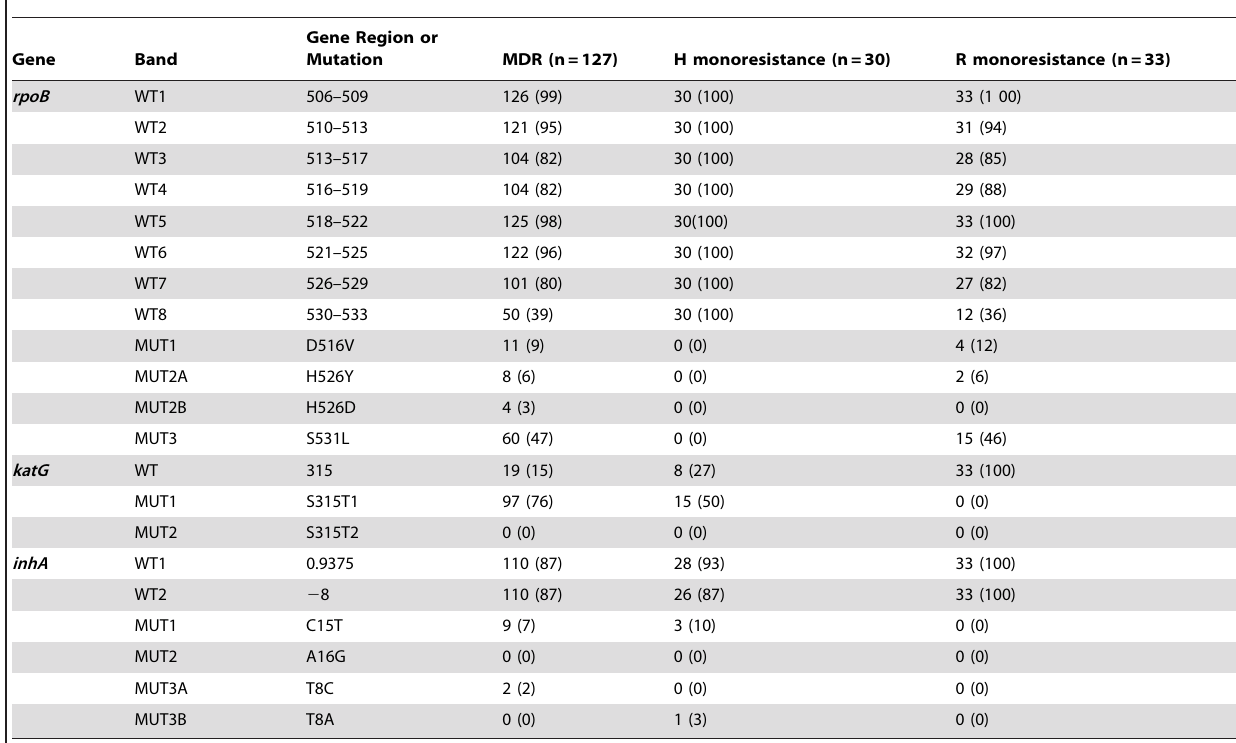
Table 3. Gene mutation patterns in resistant M.tb strains using Genotype MTBDRplus LPA.